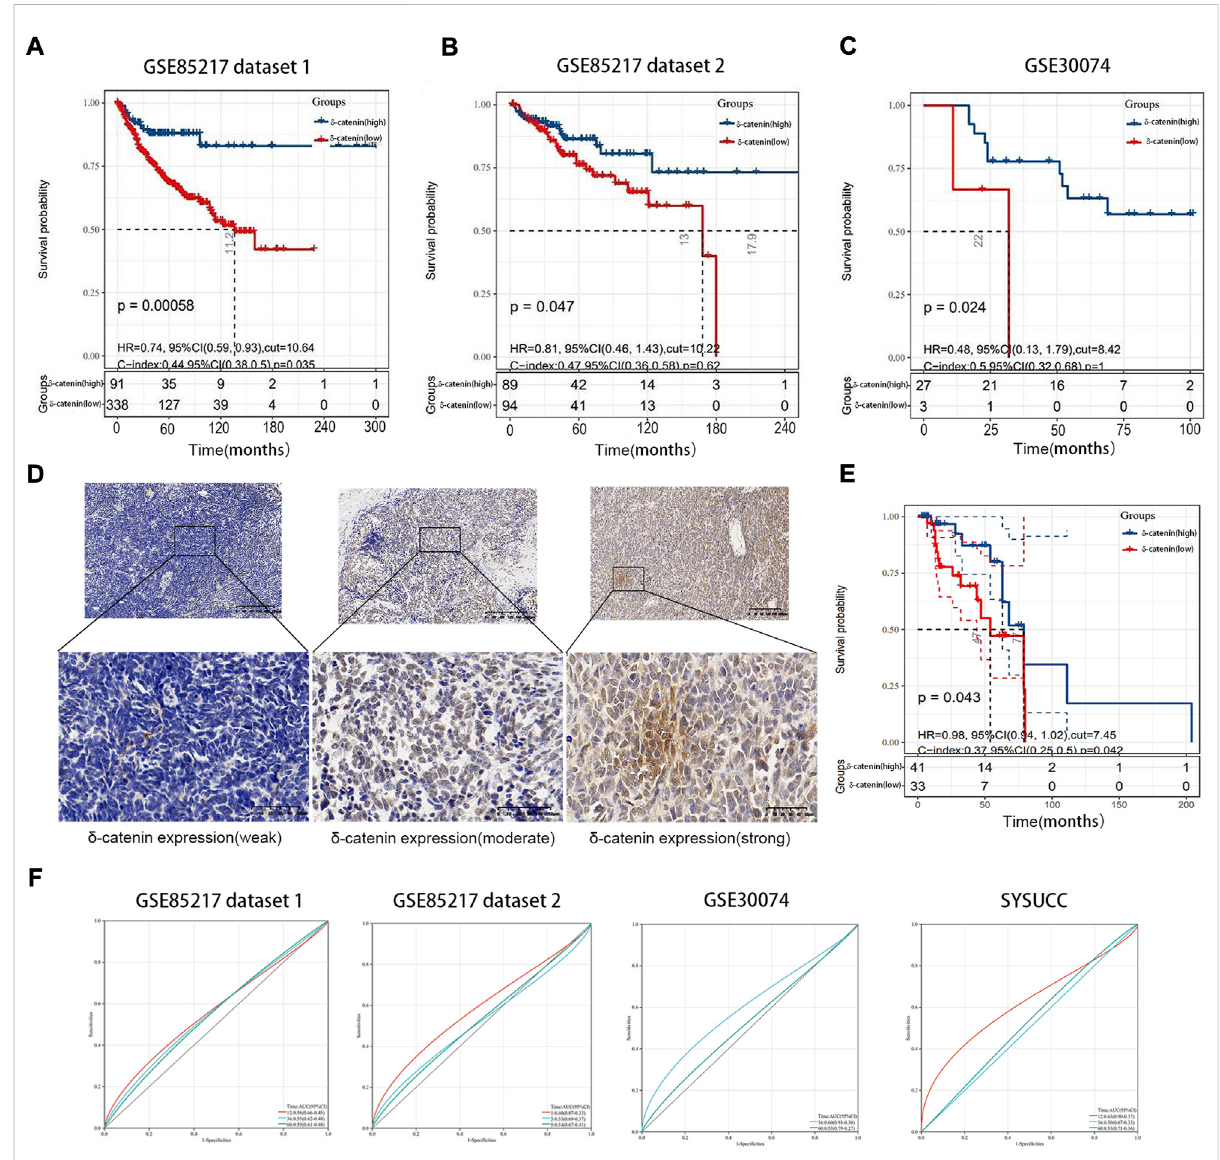
FIGURE 2 Delta-catenin expression and relevance for medulloblastoma prognosis. (A-C) Kaplan-Meier curves for medulloblastoma patients, based on delta-catenin expression. Data obtained from two nonoverlapping cohorts. (D) Immunohistochemistry reveals weak to strong delta-catenin expressioninmedulloblastomatissues. (E) Kaplan-Meiercurvefor74medulloblastomacasesattheSunYat-senUniversityCancerCenter(SYSUCC), according to delta-catenin expression. (F) ROC curves of delta-catenin expression on the overall survival rate in four cohorts and AUC corresponding to each curve. The red, blue, and green lines represent the ROC curve of 1-year, 3-year, and 5-year overall survival